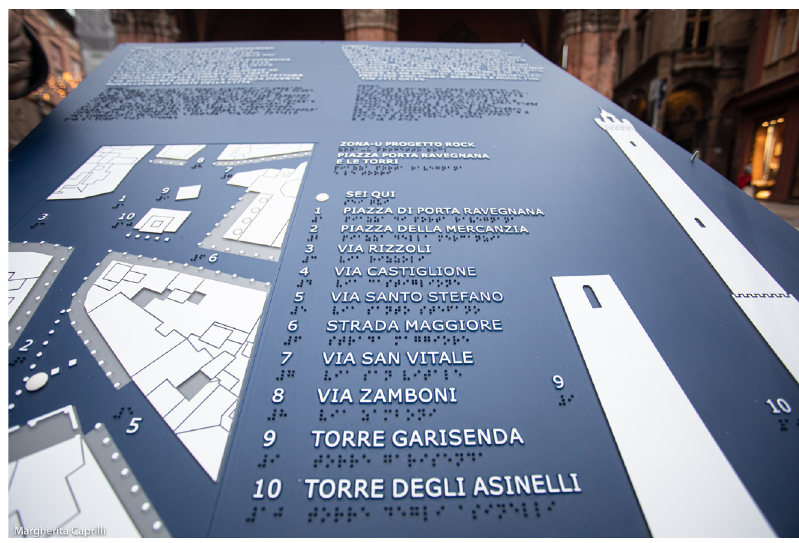
FIG. 9 The installation of the monumental tactile map U-AREA FOR ALL - ROCK BOLOGNA project. Credits: Margherita